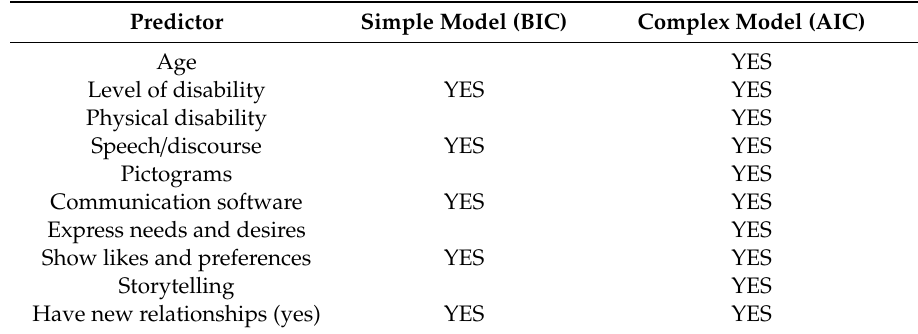
Table 6. Variables included in the two best models (simple and complex) selected with best subset regression procedure.